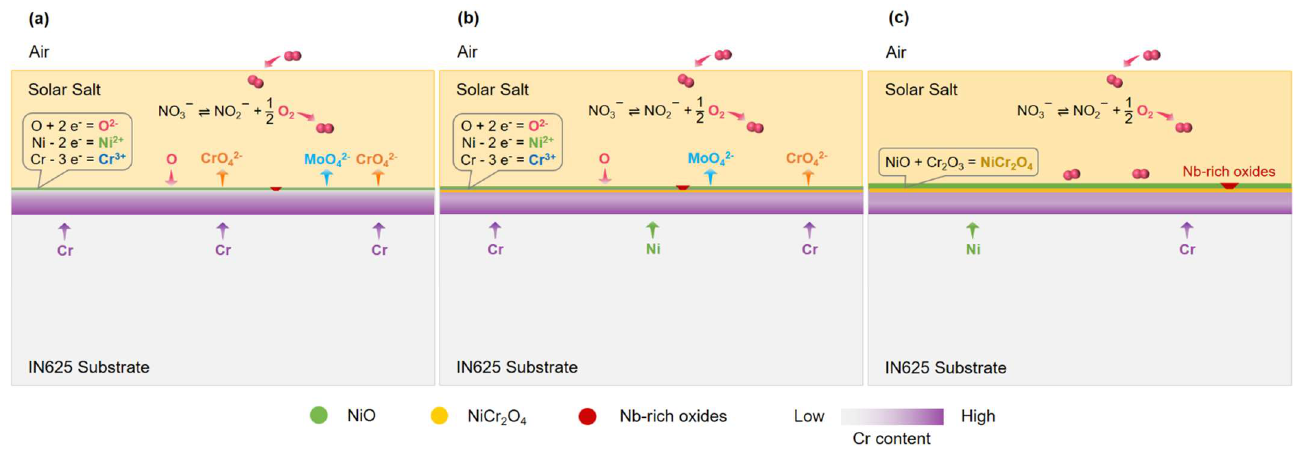
Figure 13. ( a – c ) Schematic of the corrosion process of IN625 alloy exposed to Solar Salt at 565 °C for 15 days.